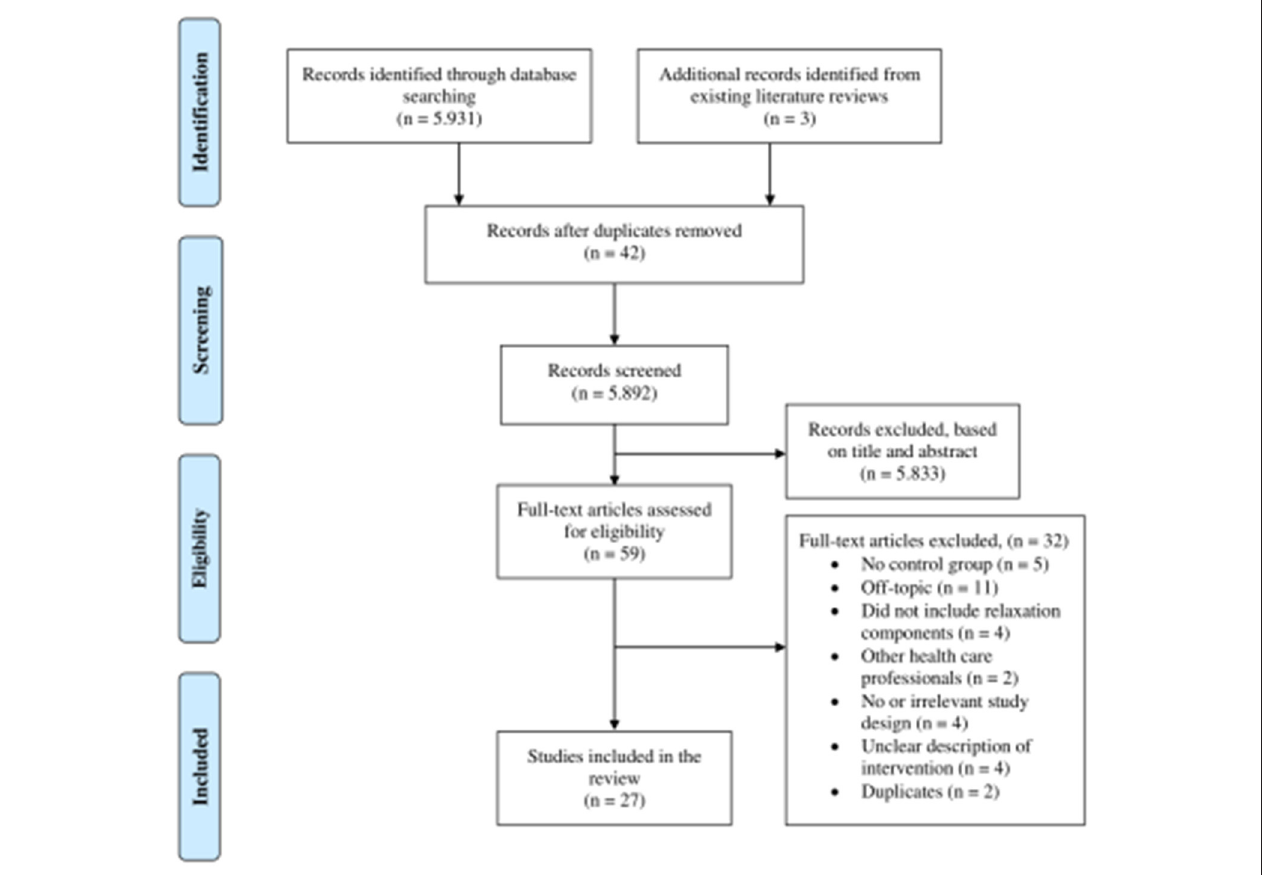
FIGURE 1 | Search strategy for the inclusion and exclusion of articles based on a modified version of PRISMA flow diagram (Moher et al.,